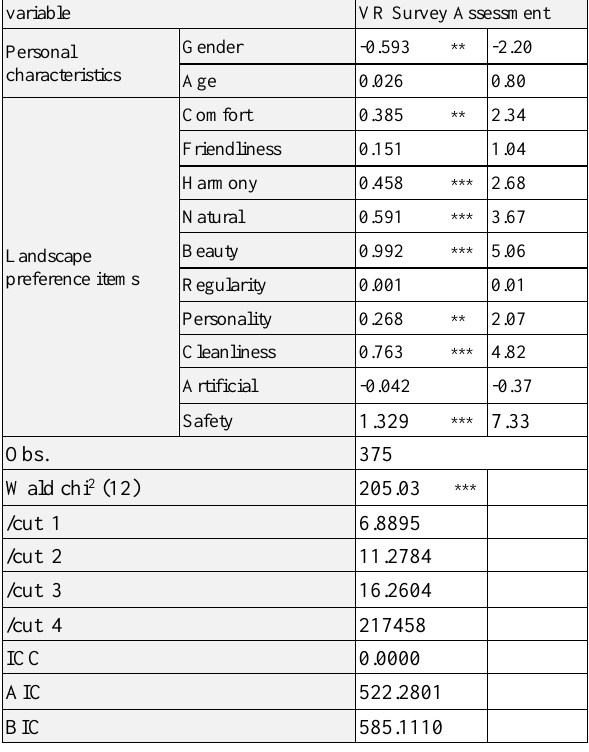
Table 2. Multilevel Ordinal Logistic